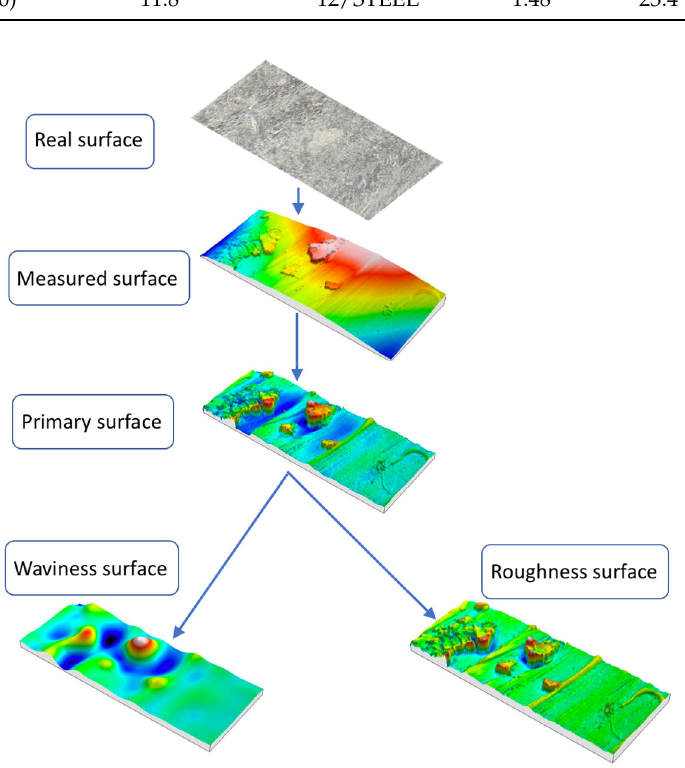
Figure 1. Measurement